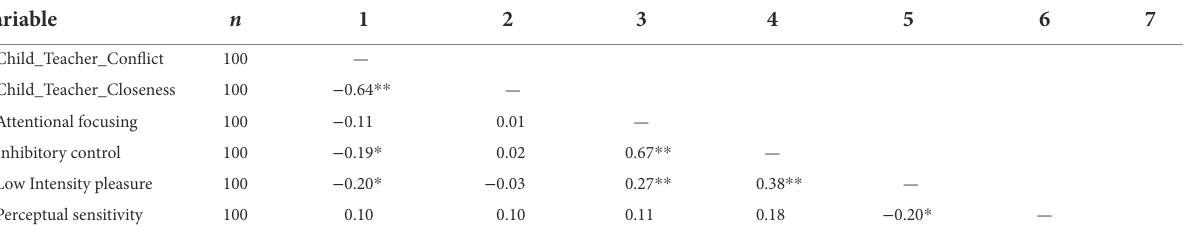
TABLE 3 Correlations for study variables (effortful